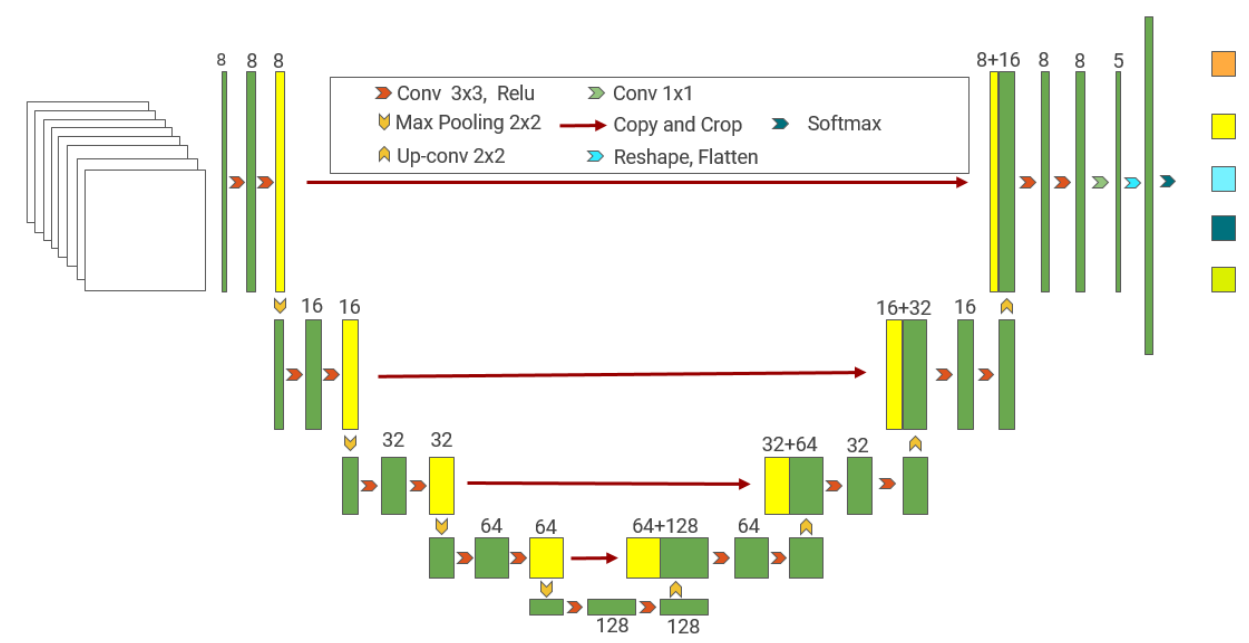
Figure 6. U ‐ Net network structure. Figure 6. U-Net network